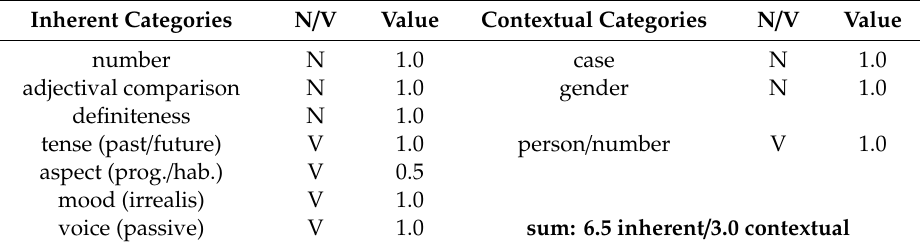
Table 3. The grammatical categories of (spoken) Standard German.